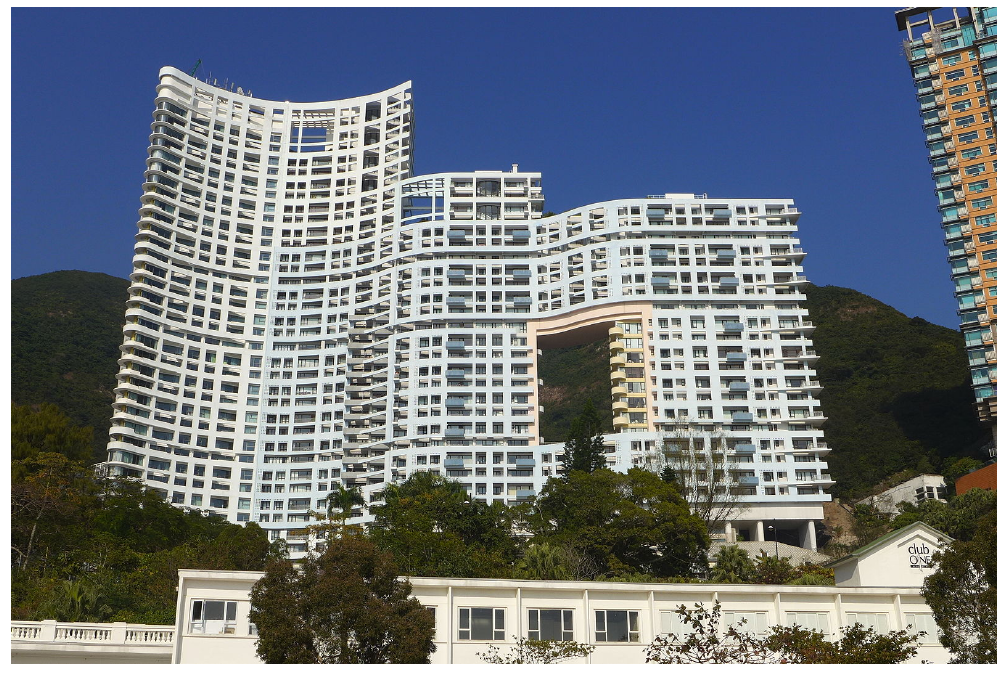
Figure 1: The Repulse Bay Image courtesy of Wing1990hk. Creative Commons Attribution 3.0.